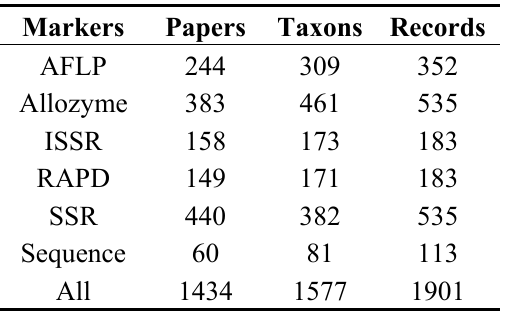
Table 1. The numbers of papers, taxa and records for the five molecular markers and nucleotide sequences included in this study.